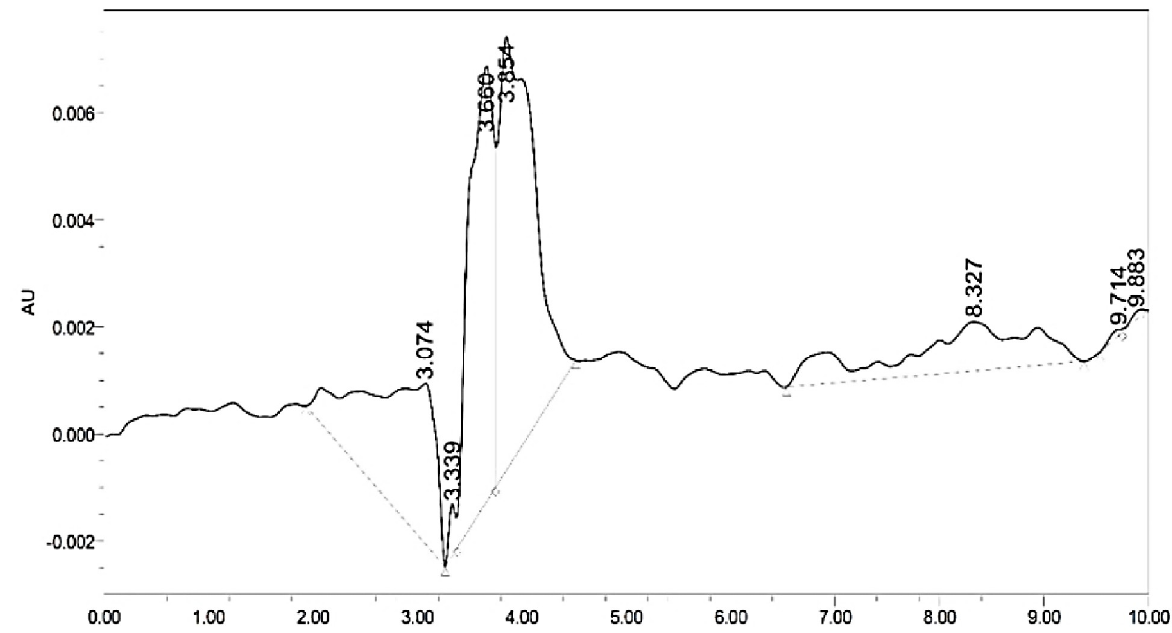
Fig 9. Detailed UPLC chromatogram of pure sunflower oil